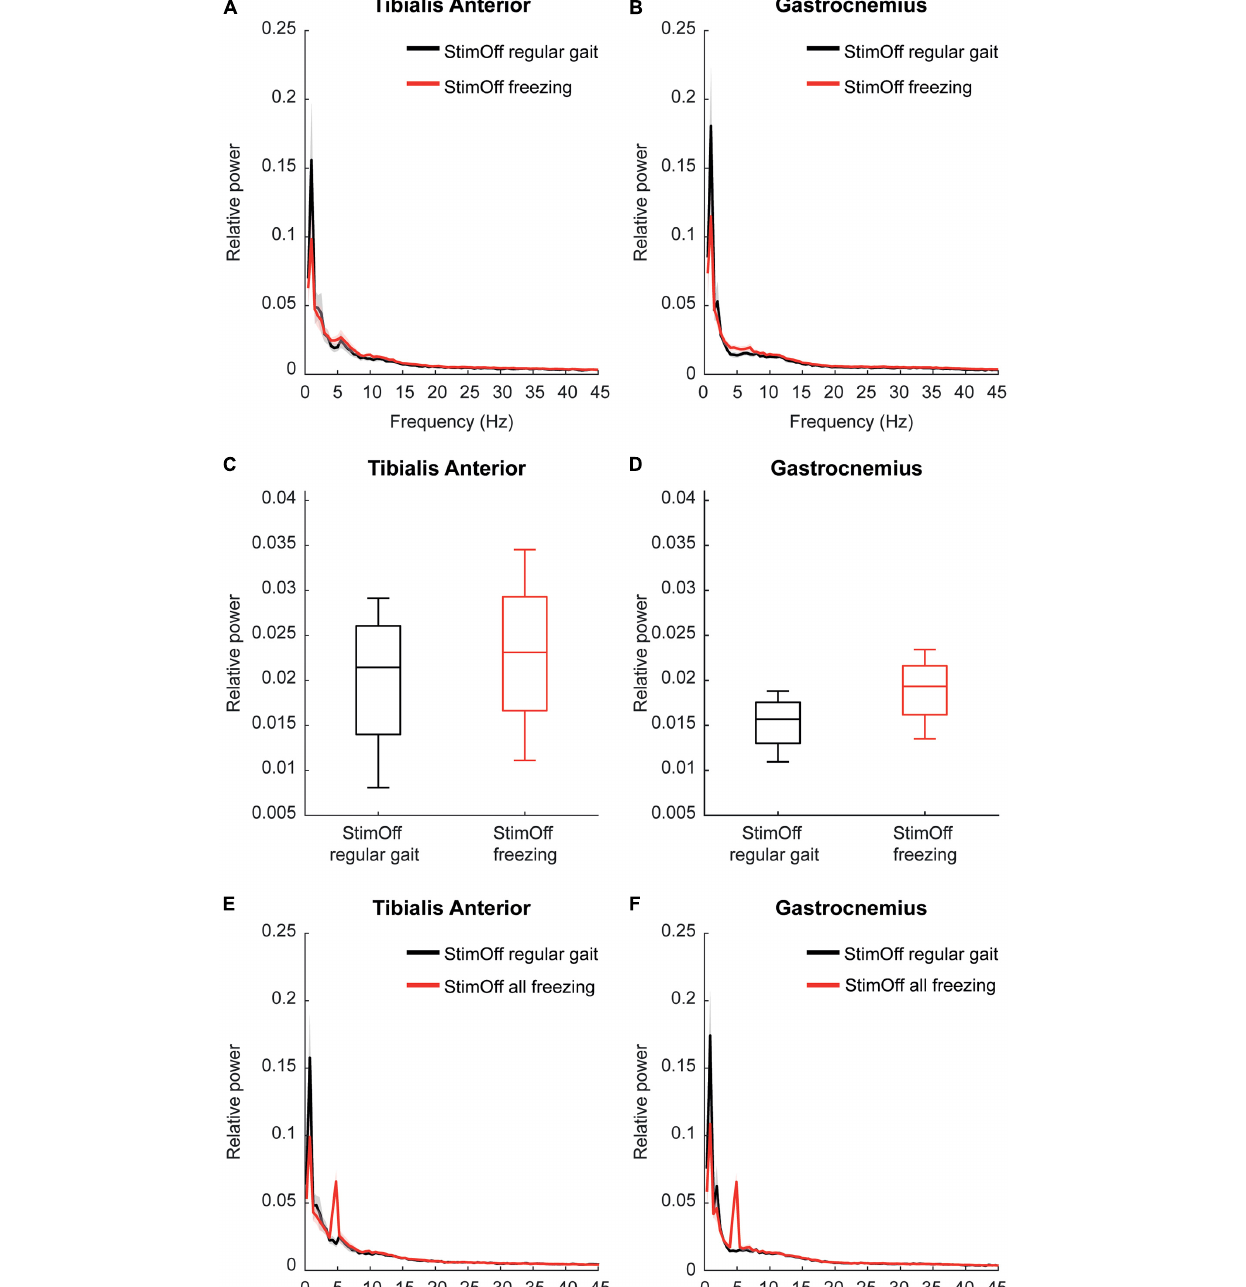
Frontiers in Human Neuroscience |